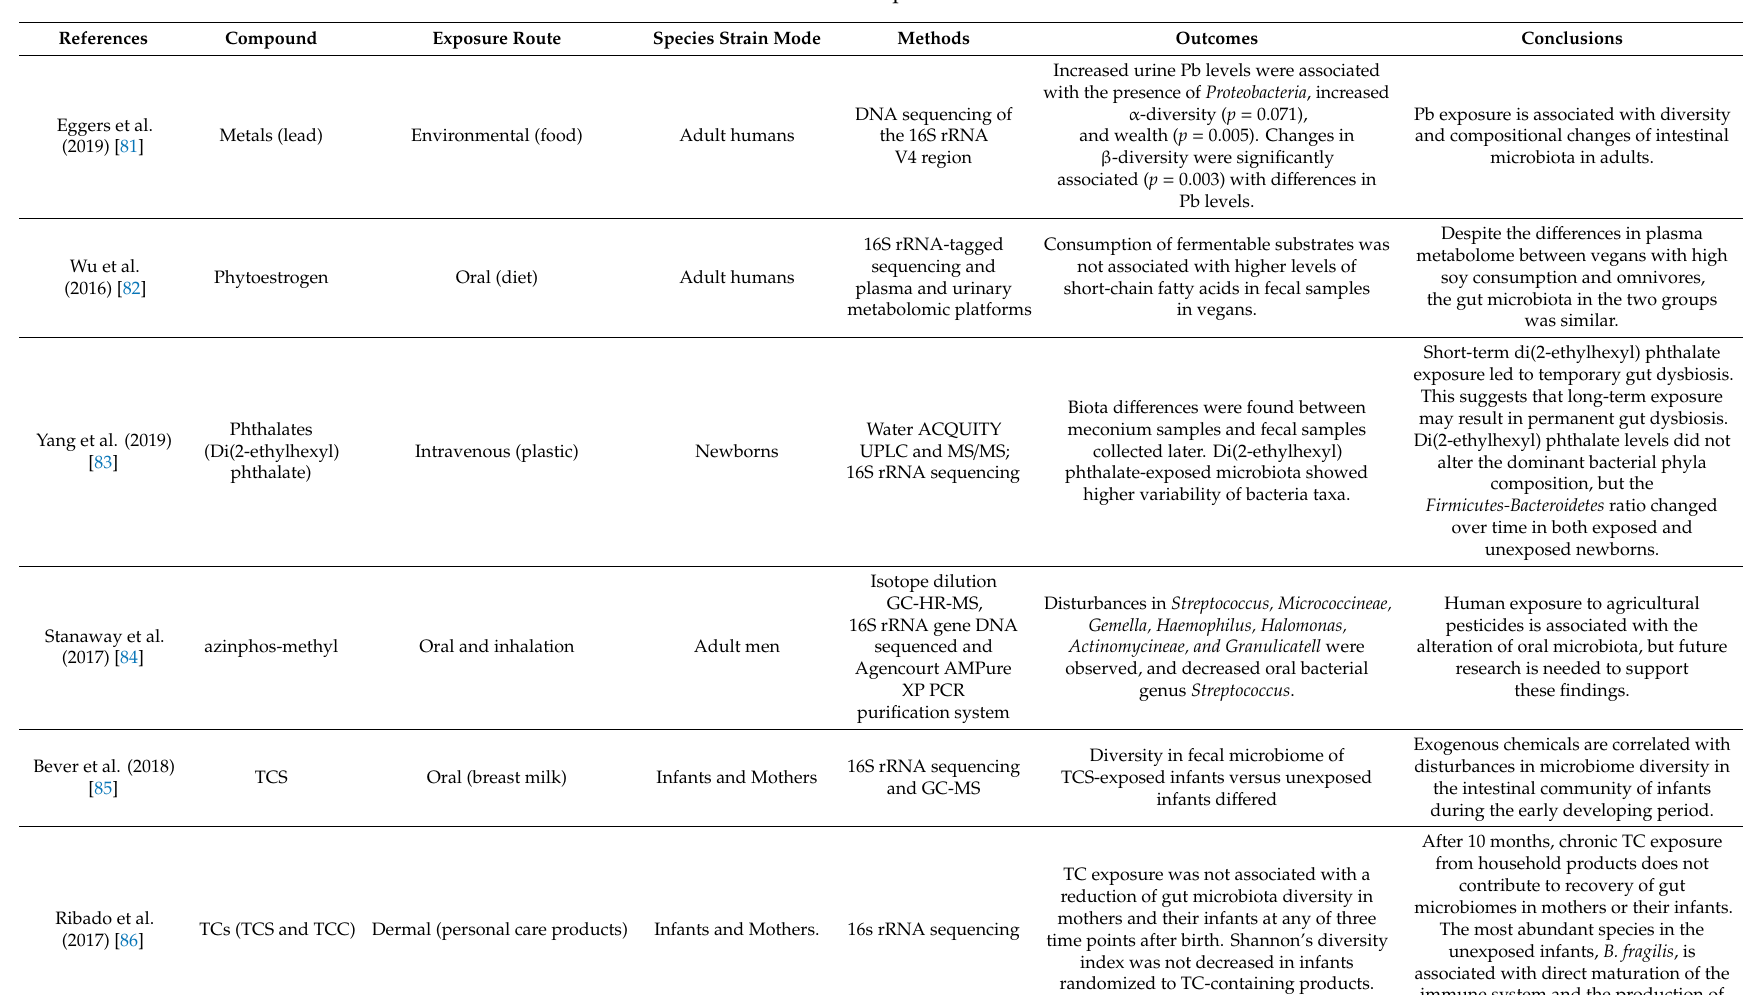
Table 3. E ff ects of endocrine disruptors on the human